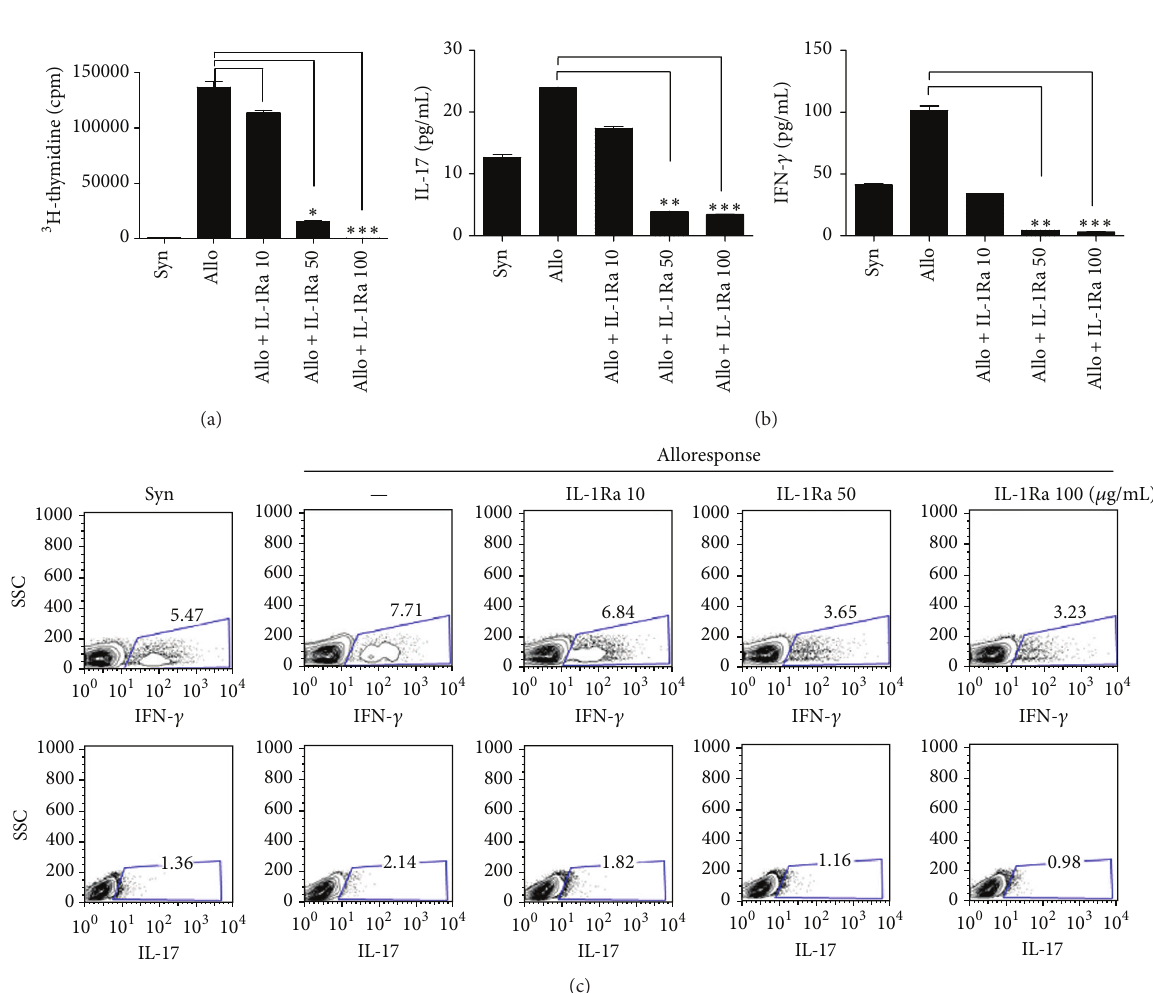
Figure 3: Treatment with IL-1 receptor antagonist (IL-1Ra) reduces the alloreactive T cell response. Antigen-presenting cells (APCs) from C57BL/6 mice (an allogeneic stimulator) were cocultured with T cells from BALB/c mice (responder cells) and subjected to the indicated stimuli for 3 days. (a) The proliferation of alloreactive T cells was quantified by MLR. (b) The concentrations of IL-17 and interferon- (IFN-) 𝛾 in the culture supernatants were measured using enzyme-linked immunosorbent assays (ELISAs). (c) Flow cytometric assessment of the numbers of Th1 cells and Th17 cells. ∗ 𝑃 < 0.05 , ∗∗ 𝑃 < 0.01 , and ∗∗∗ 𝑃 < 0.001 . Data are representative of 2 independent